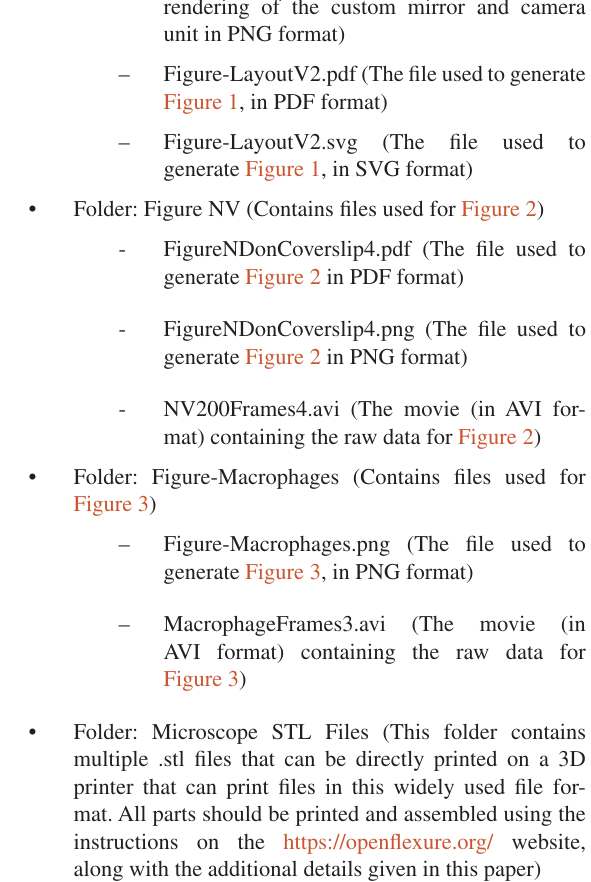
Figure-LayoutV2.pdf (The file used to generate Figure 1, in PDF format) Figure-LayoutV2.svg (The file used to generate Figure 1, in SVG format) Folder: Figure NV (Contains files used for Figure 2) - FigureNDonCoverslip4.pdf (The file used to generate Figure 2 in PDF format) - FigureNDonCoverslip4.png (The file used to generate Figure 2 in PNG format)